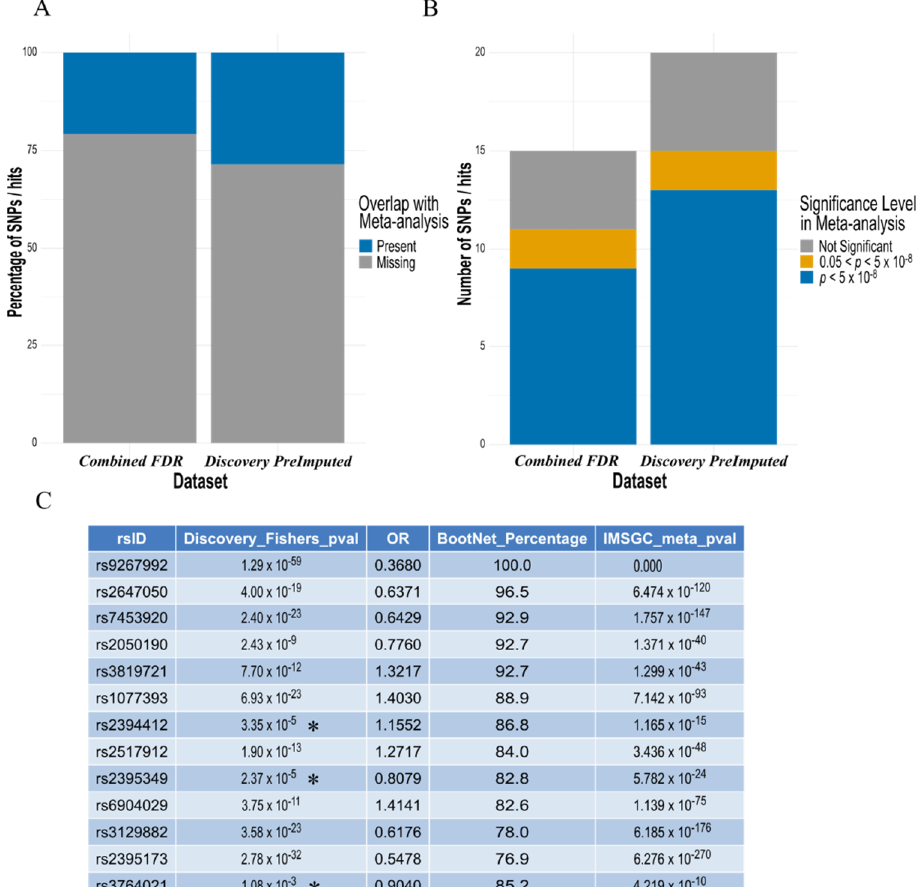
Figure 5. The majority of SNP ‘hits’ identified by the elastic net model, also present in the IMSGC meta-analysis, are found to be increasingly ‘significant’ by conventional methods in the largest MS dataset. ( A ) Around 25% of the hits identified by both the ‘combined FDR analysis’ (Tables 4 and S2) and the pre-imputed discovery dataset were present in the IMSGC meta-analysis. ( B ) For the SNPs that were present in the meta-analysis, the majority were found to have P value below the conventionally adopted GWAS threshold ( p < 5 × 10 −8 ) in both analyses. ( C ) Comparison of the 13 SNPs found to reach GWAS level significance in the IMSGC meta-analysis with those identified by the elastic net model in the discovery dataset, confirmed all hits with increasing significance in the meta-analysis compared to the discovery p value. This also included at least three SNPs identified by the elastic net model with p values not reaching GWAS significance threshold in the discovery dataset (denoted with an Asterisk*).